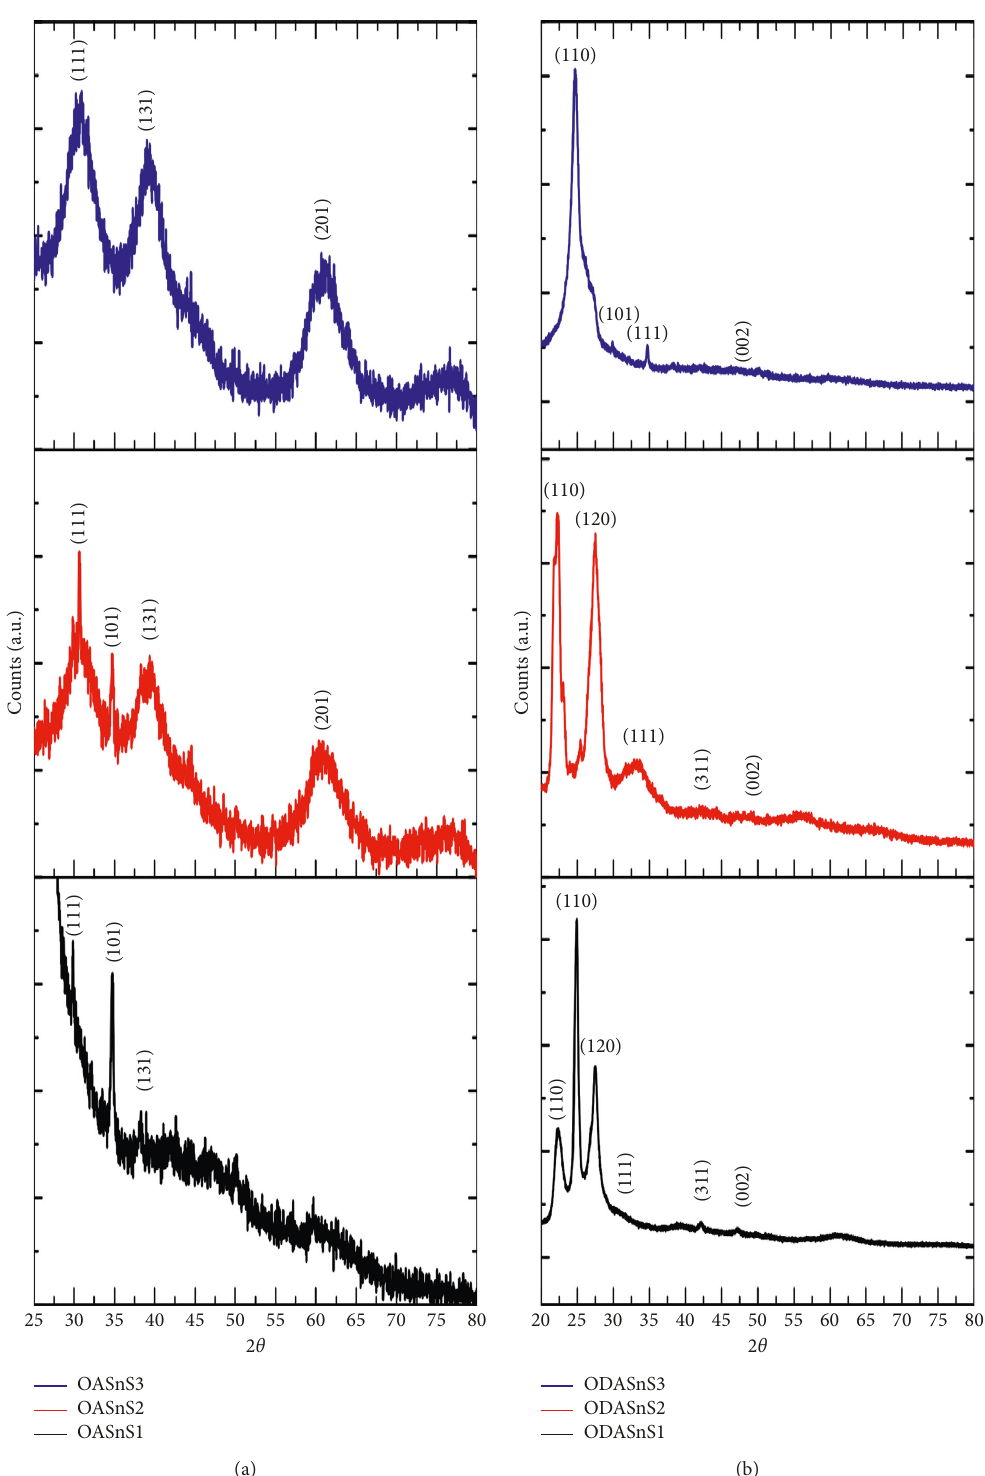
Figure 1: XRD diffraction pattern of OASnS (a) and ODASnS